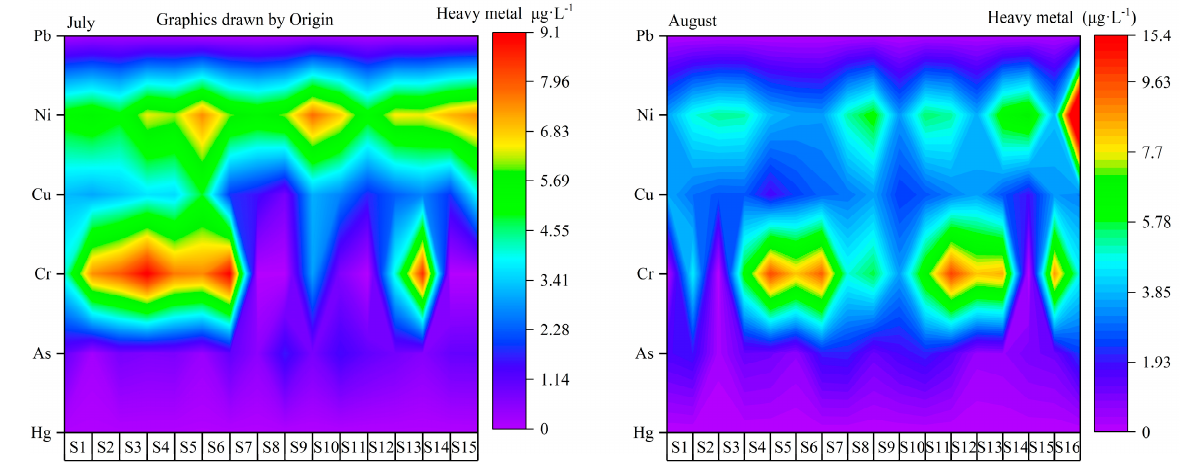
Figure 6. Spatiotemporal distribution of heavy metal concentration at 17 locations within the Maotiao River Basin (Gizhou province, SW China) in 2020.